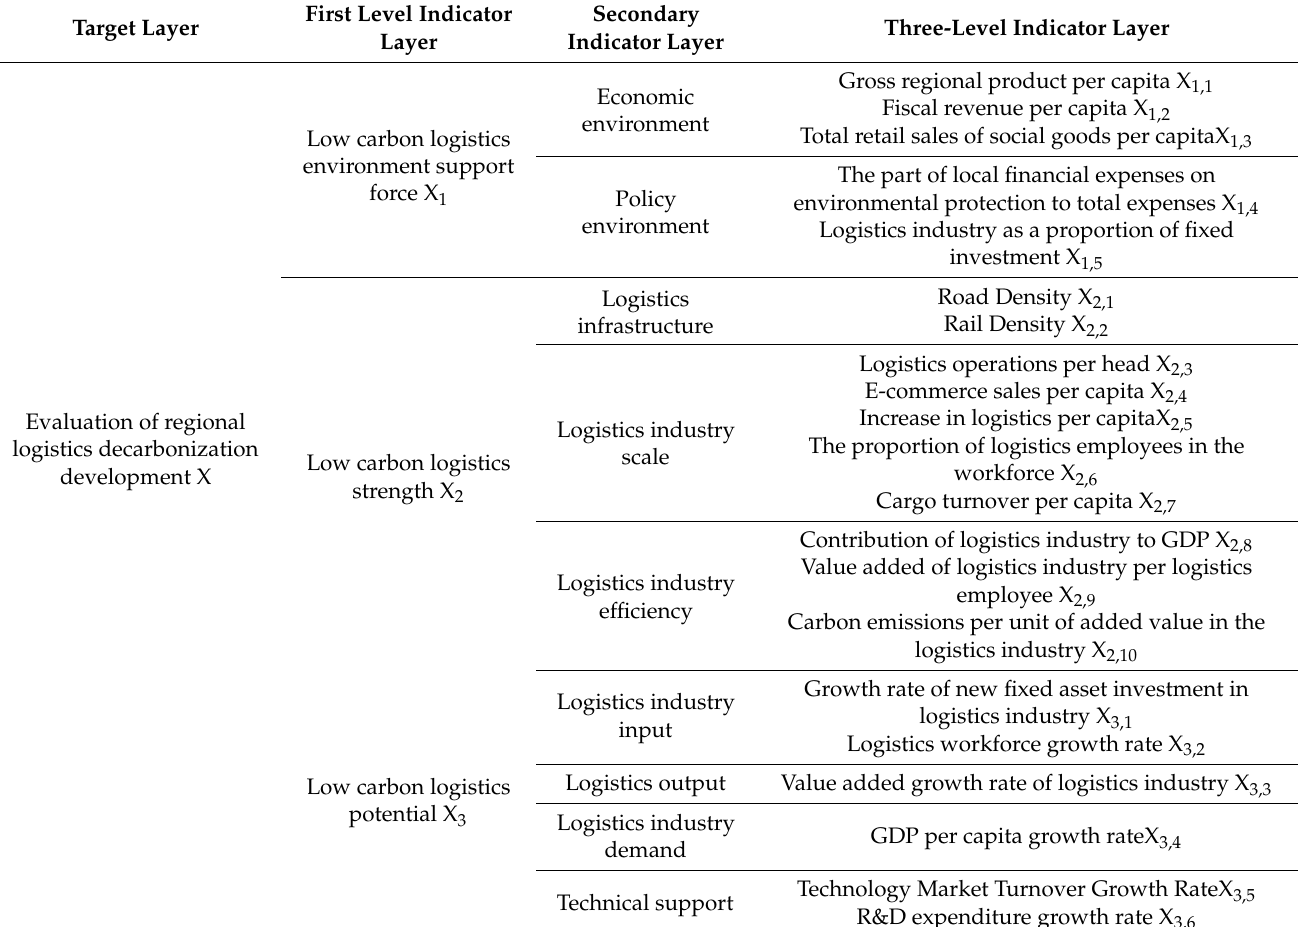
Table 1. Regional Logistics Decarbonization Evaluation Index